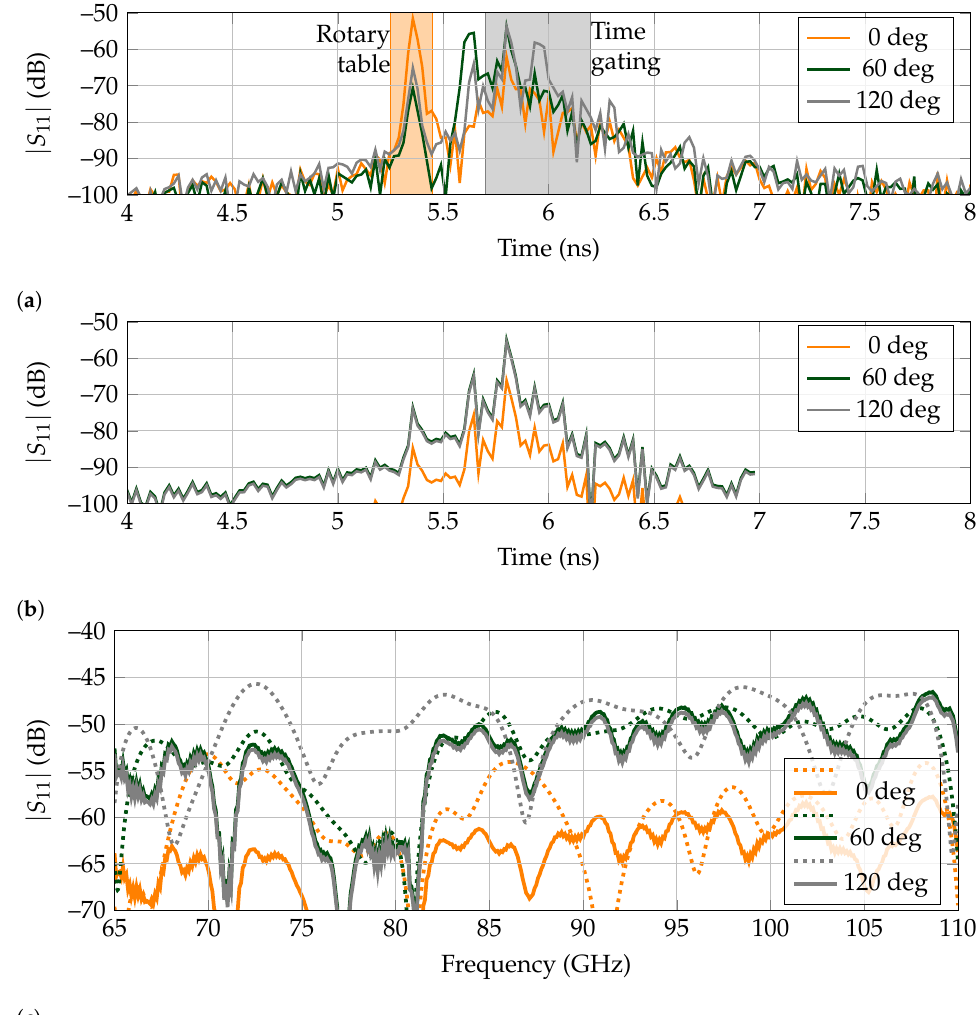
Figure 5. Selected backscattered responses for the low-Q tag when encircled by a small metallic rod. ( a ) Measured time responses. Time gating is marked in gray and spans from 5.7 ns to 6.2 ns. The early reflection of the rotary table is marked in orange. ( b ) Extracted time-domain backscatter response of the tag by the RPCA. ( c ) Frequency domain of extracted signals. Time gating results are represented by dashed lines, whereas RPCA by the solid